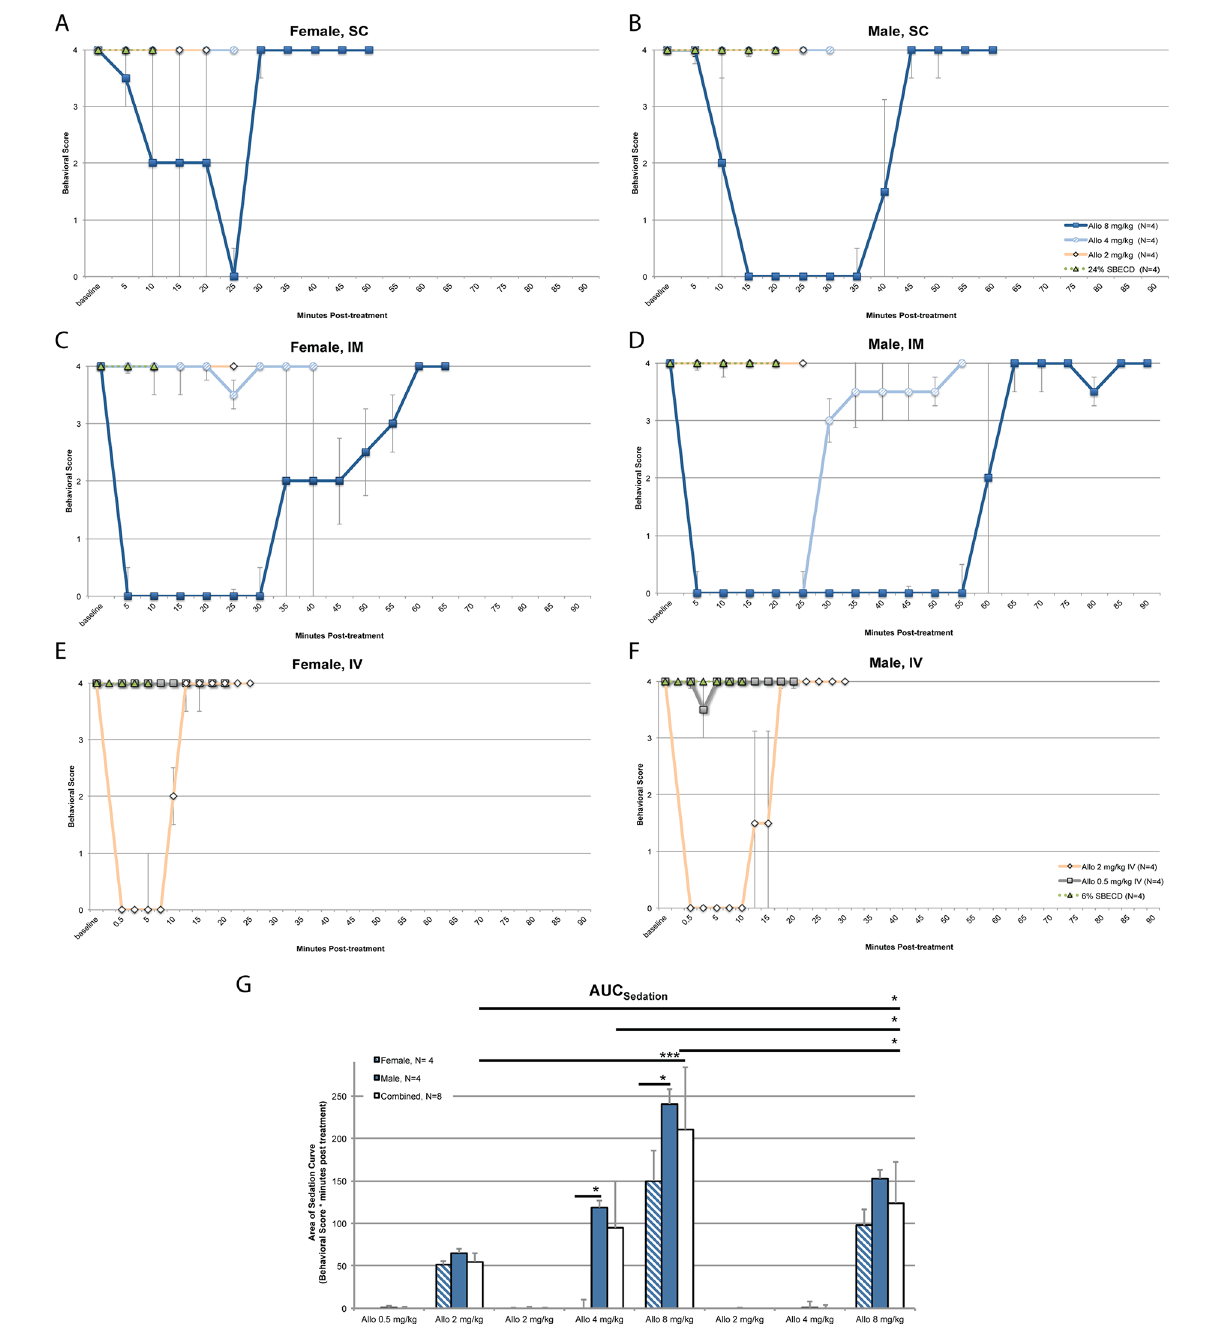
Fig 5. Allopregnanolone (Allo) dose-response comparison by subcutaneous (SC), intramuscular (IM), and intravenous (IV) routes of administration. Ovariectomized female rats (left panel) were compared to age-matched male rats (right panel) following SC (A. and B.), IM (C. and D.), or IV (E. and F.) bolus injection and challenged with a motor coordination behavioral task to assess level of sedation at timed intervals until recovery. SC/IM formulation: 6 mg/ml Allo solution in 0.9% sodium chloride with 24% sulfobutyl ether β -cyclodextrin sodium (SBECD). IV formulation: 1.5 mg/ml Allo solution in 0.9% sodium chloride with 6% SBECD. The volume of vehicle administered was equal to the volume administered with the highest dose, i.e. 8 mg/kg (SC/ IM) or 2 mg/kg (IV). Balance Beam Behavioral Scoring System: 4 = reach platform; 3 = takes steps; 2 = all paws on top; 1 = clasp; 0 = fall. n = 4, interval points represent mean value ± SEM. Area bound by sedation curve as an indicator of rapid Allo target engagement. G. The area bound by the sedation curve (above the curve; Fig 5A – 5F) (AUC sed ) was calculated to determine the sedative component of GABA A receptor activation in the brain as an indicator of Allo delivery. AUC sed was calculated and expressed as behavioral score (a score between 4 and 0) multiplied by minutes post-treatment. Sex differences in the Allo-induced sedation response were determined. * p < 0.05, ** p < 0.01, n = 4, bars represent mean value ± SEM.